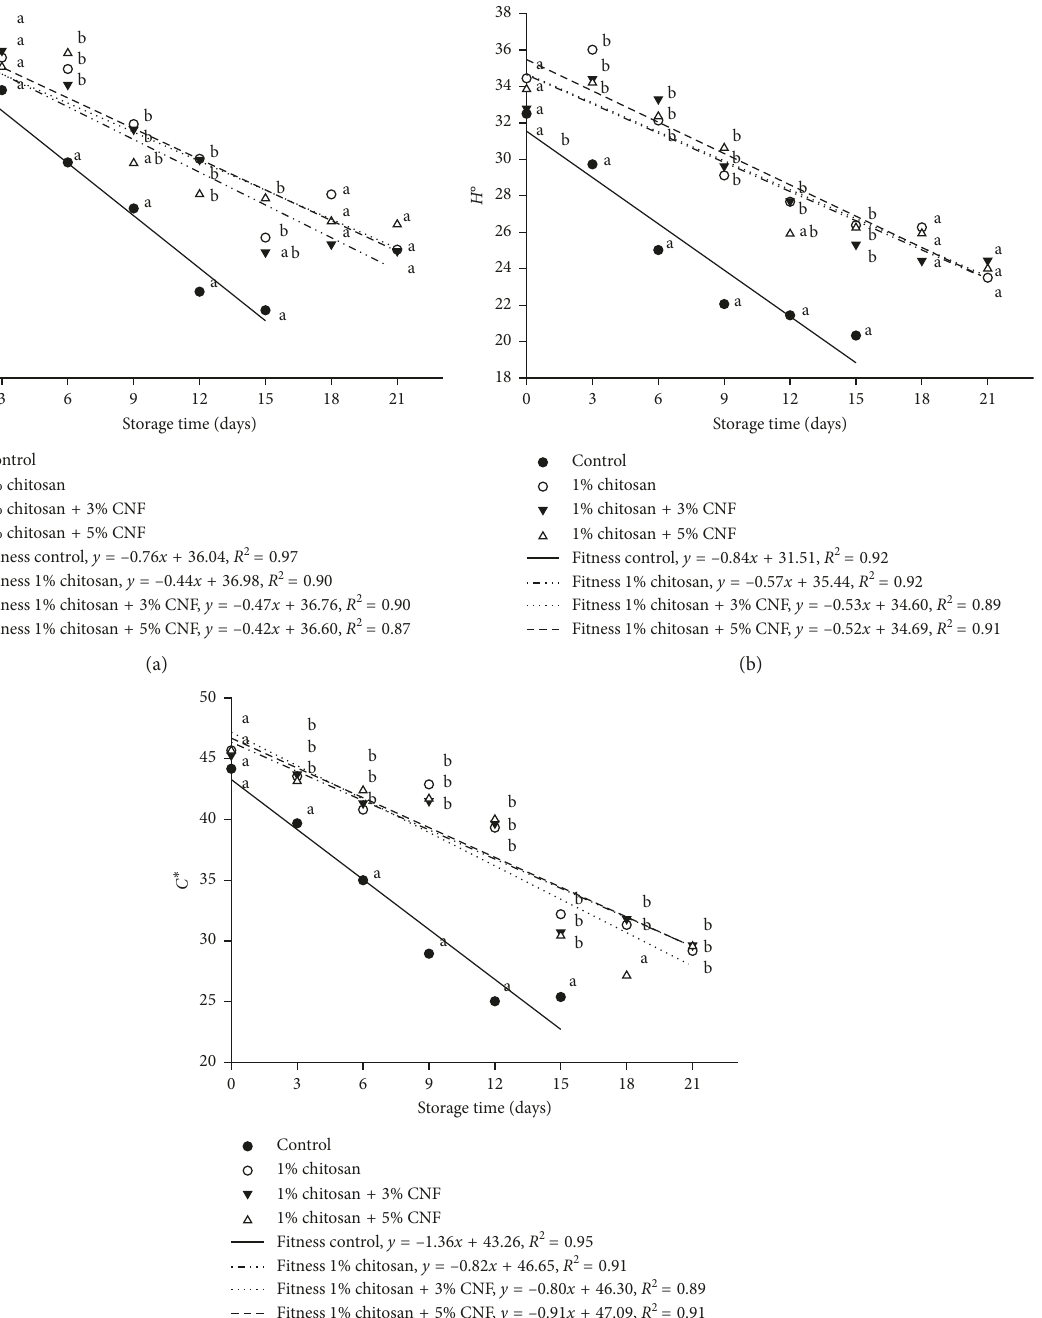
Figure 3: Average values of L , h ° , and C of coated and uncoated strawberries. Same letters in the same storage time denote that averages do not differ by the Tukey test at 5% ∗ ∗